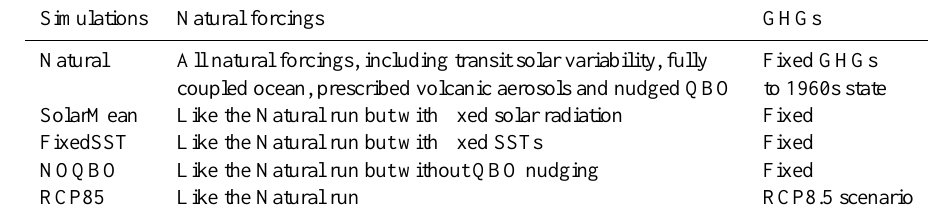
Table 1. Overview of fully coupled CESM-WACCM simulations (1955–2099). Simulations Natural forcings GHGs Natural All natural forcings, including transit solar variability, fully Fixed GHGs coupled ocean, prescribed volcanic aerosols and nudged QBO to 1960s state SolarMean Like the Natural run but with fixed solar radiation Fixed FixedSST Like the Natural run but with fixed SSTs Fixed NOQBO Like the Natural run but without QBO nudging Fixed RCP85 Like the Natural run RCP8.5